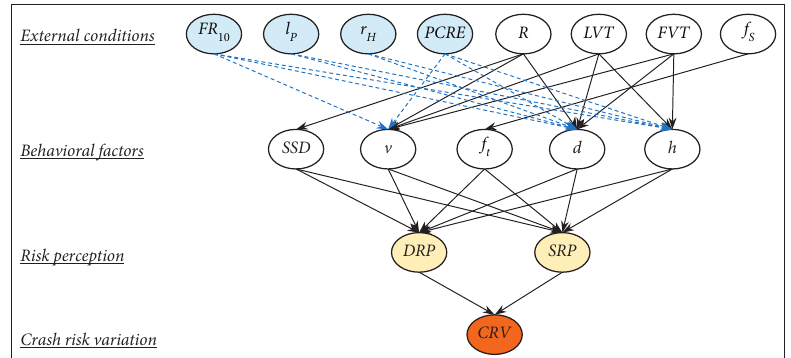
Figure 4: The hierarchical hybrid BN structure, wherein the base layer was the external conditions of the roadway and traffic flow (ellipses in blue), and the risk perception layer contains two latent variables (ellipses in light orange) bridging the explanatory variables and the outcome of crash risk variations (ellipse in dark